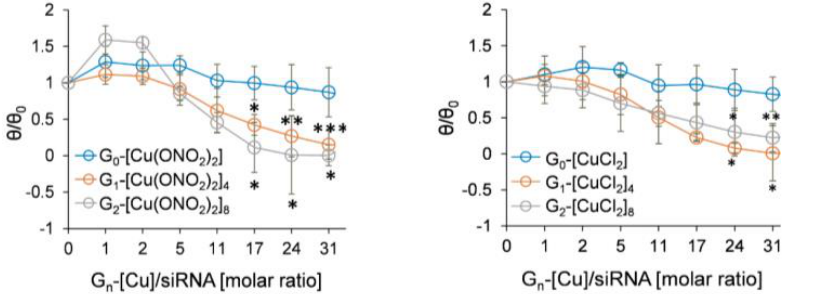
Figure 7. ( A ) CD spectra of siRNA at the presence of G n -[Cu] metallodendrimers in increasing molar ratios. G n -[Cu] / siRNA ( B ) Changes in the mean residue ellipticity ( θ ) of siRNA at λ = 258 nm in the presence of dendrimers. [siRNA] = 1 µ M. Results are represented as mean ± standard deviation (SD), n = 3. Statistically significant di ff erences compared to the control cells p ≤ 0.05 (*); p ≤ 0.01 (**); p ≤ 0.001 (***). Cells treated with pro-apoptotic siRNA silences the expression of anti-apoptotic genes, which may result in the induction of apoptosis and, consequently, a decrease in cancer cell viability [4,34]. Cancer cells use di ff erent mechanisms to evade apoptosis and favour tumour progression. Family members of Bcl-2 proteins control mitochondrial-dependent apoptosis. High levels in these anti-apoptotic